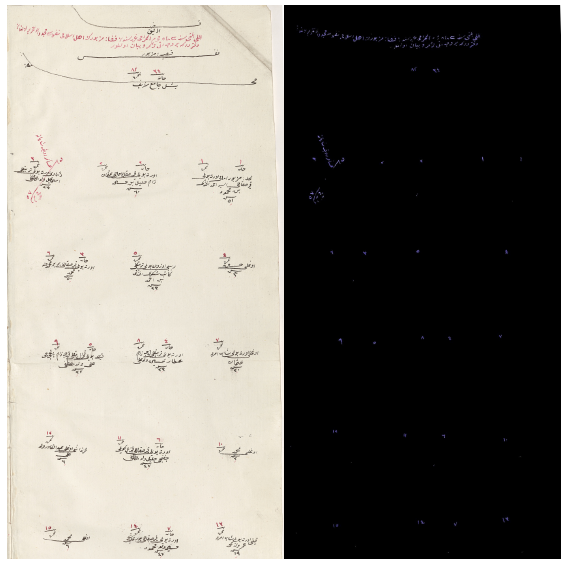
Figure 3. In the left, the original register image is shown. In the right, the resulting image after applying a red color mask is